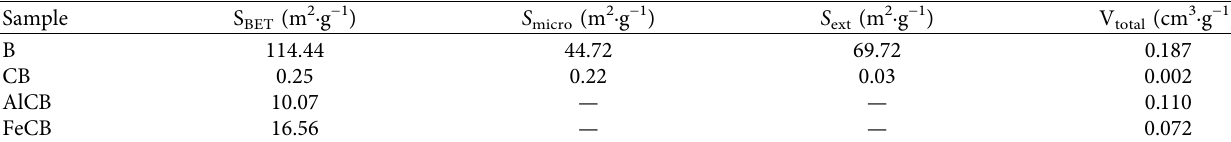
Table 1: Textural parameters of B CB, AlCB, and FeCB samples.